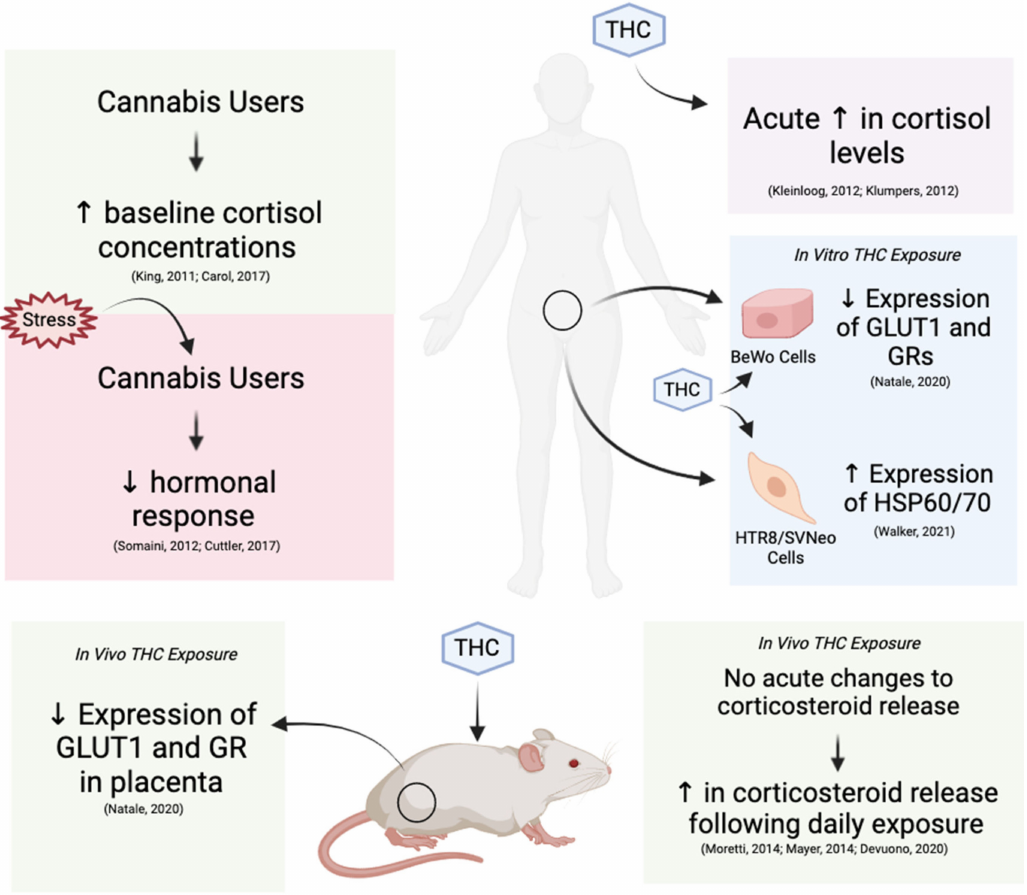
Figure 6. Systemic, cellular, and molecular changes to glucocorticoid and glucocorticoid receptors following THC exposure in humans and mice. Chronic cannabis usage in humans increases baseline cortisol levels and decreases reactivity to stress. Both humans and mice experience an increase in glucocorticoid levels following THC exposure. Decreased expression of GLUT1 and GRs have been observed in both species in response to